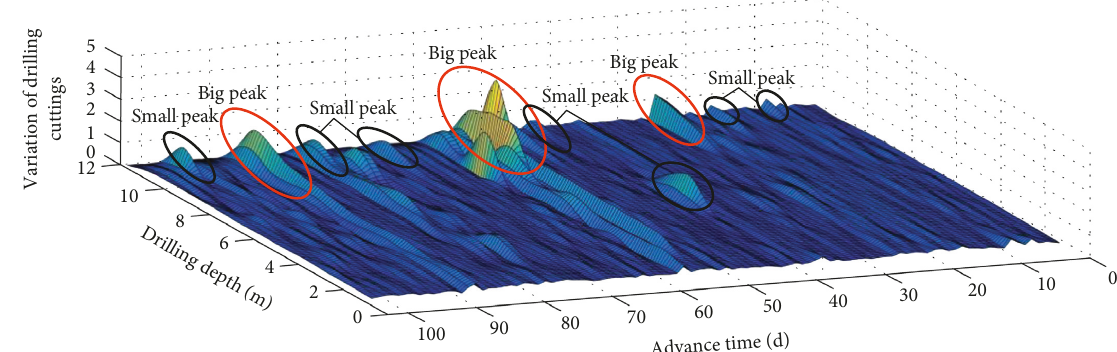
Figure 8: Relationship between the variation of drilling cuttings and coalface advanced